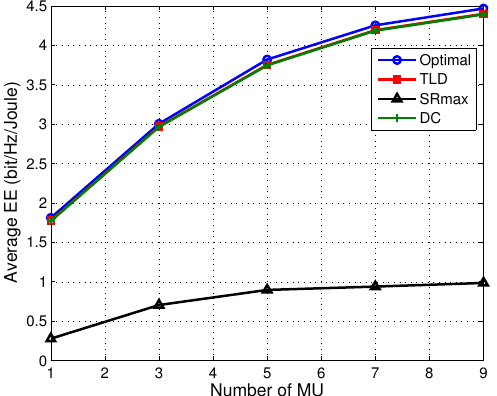
Figure 8. Average EE versus MU number with P m = 30 dBm, C = 5 bits/s/Hz and P c = 2